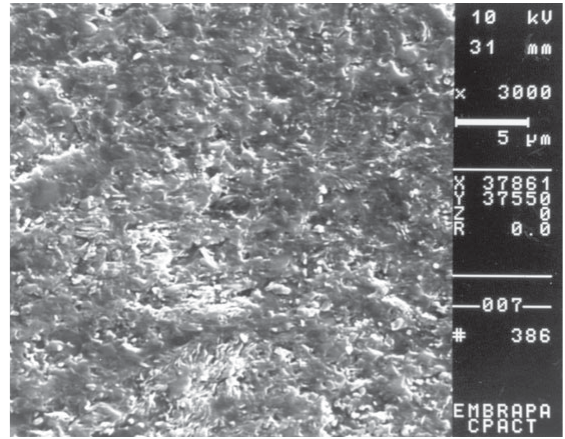
Figure 1. SEM micrography of Alert surface at aging time 0 (SEM original magnification 10000 × ).